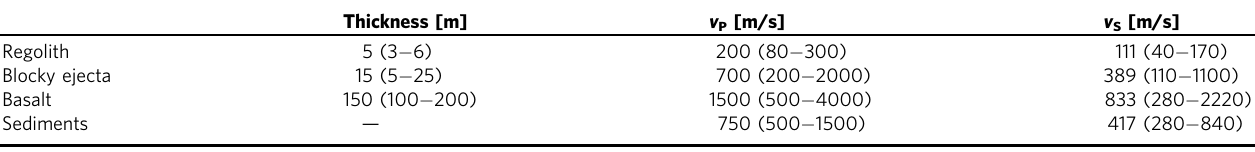
Table 2 Modi fi ed near-surface reference model (referred to as model 2). The numbers in brackets mark the full range explored in the inversion (i.e. bounds of the depth-dependent multizonal prior